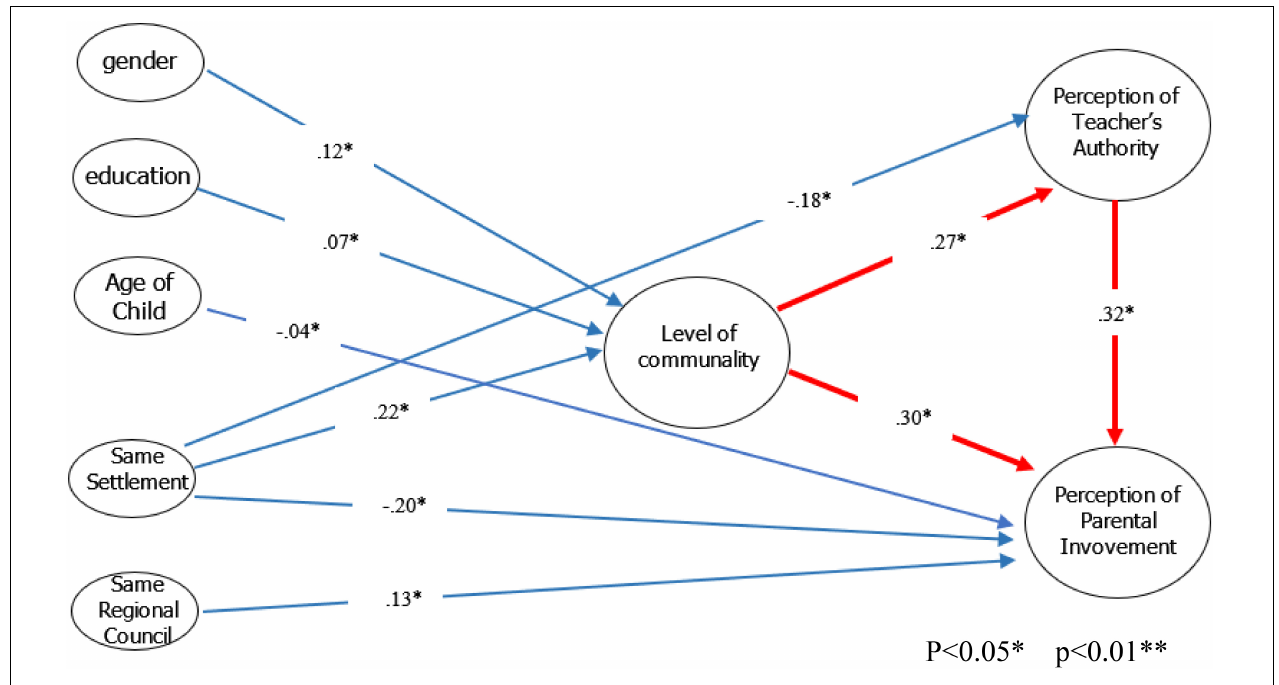
FIGURE 2 | Resulting path coefficients of the proposed research